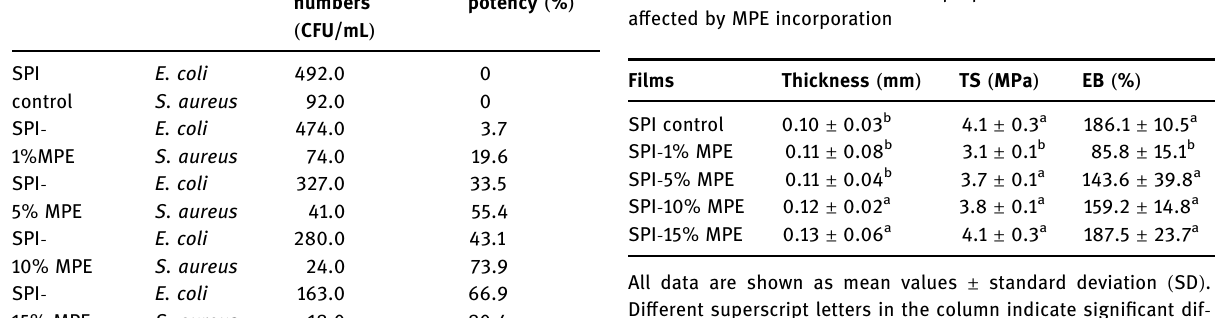
Table 4: Thickness and mechanical properties of SPI fi lms